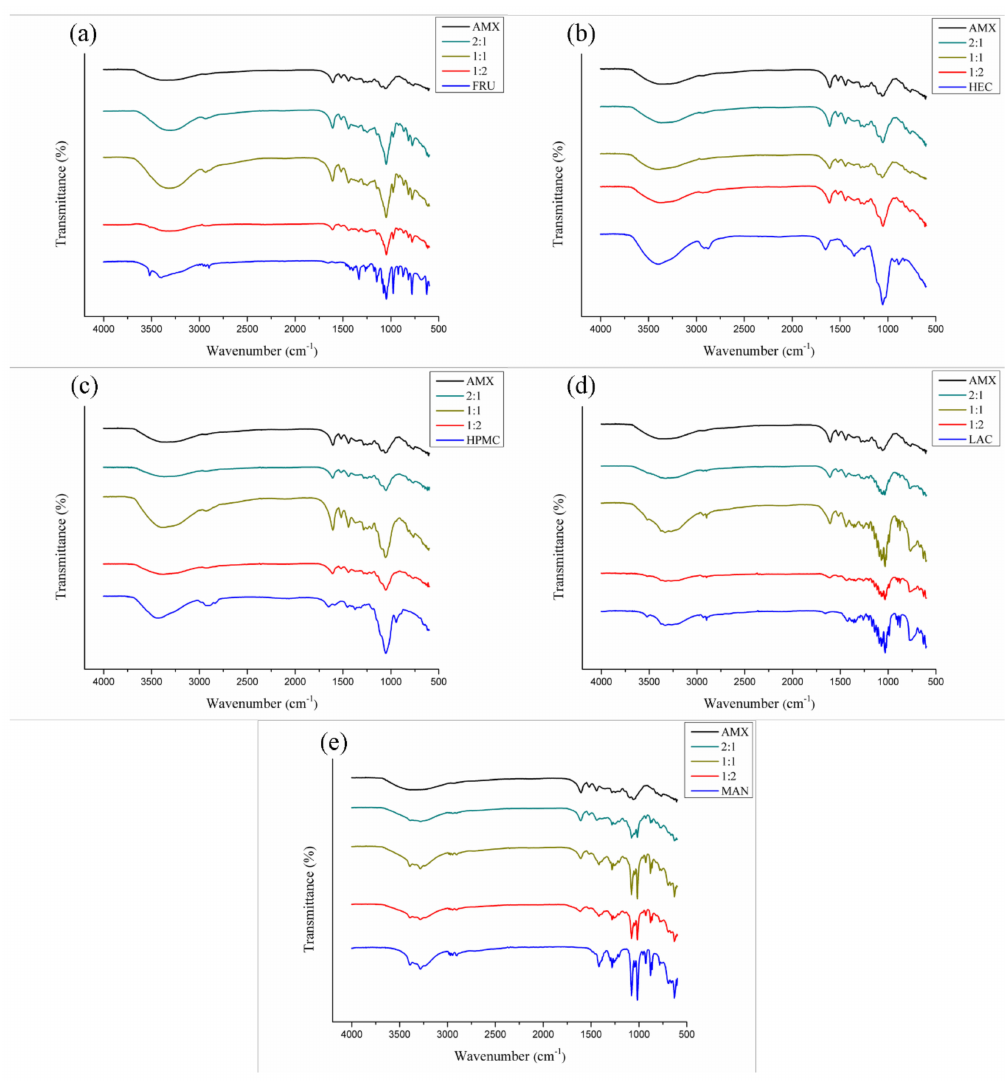
Figure 6. FTIR spectra for binary mixtures of AMX and pharmaceutical excipients: fructose ( a ), hydroxyethylcellulose ( b ) and hydroxypropylmethylcellulose ( c ), lactose ( d ), and mannitol ( e